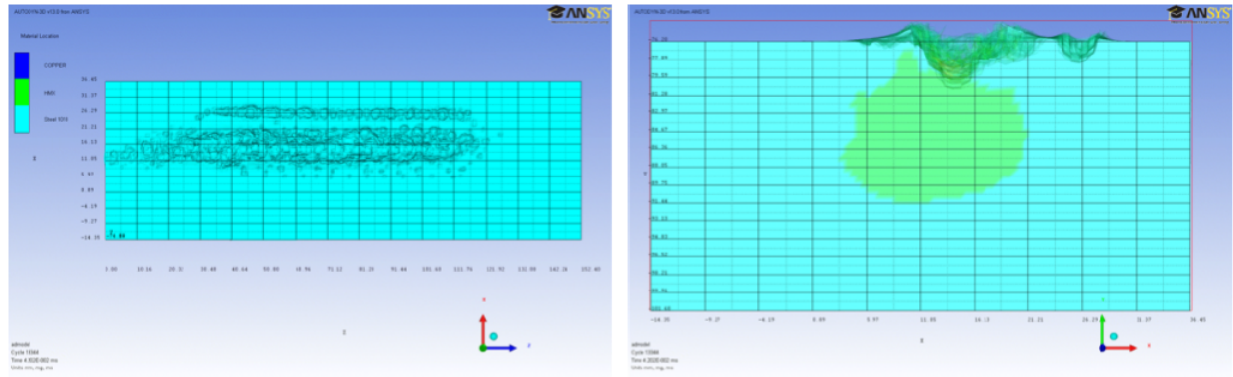
Figure 13. The penetration profile can be seen on the top of the target and in a cross section of the target at a 3 inches (7.62 cm) standoff distance after 15 µs (top left and top right pictures respectively). The bottom picture above shows the jet spreading due to the distance traveled by the